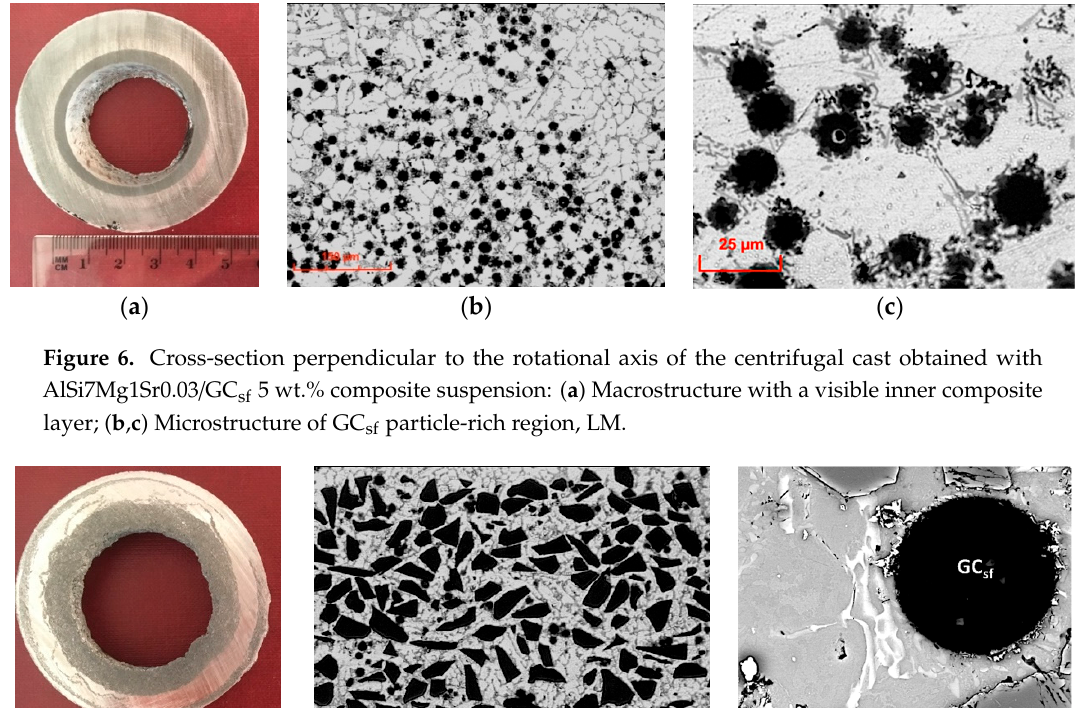
Figure 5. Cross-section perpendicular to the rotational axis of the centrifugal cast obtained with the AlSi7Mg1Sr0.03/SiC 15 wt.% composite suspension: ( a ) Macrostructure with visible outer composite layer; ( b ) and ( c ) Microstructure of the SiC p particle-rich region, LM.